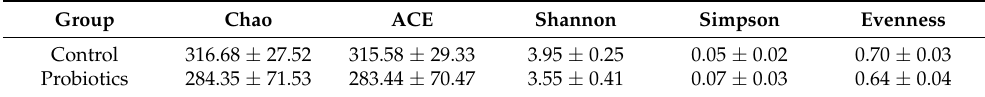
Table 2. Statistical analysis of microbial alpha